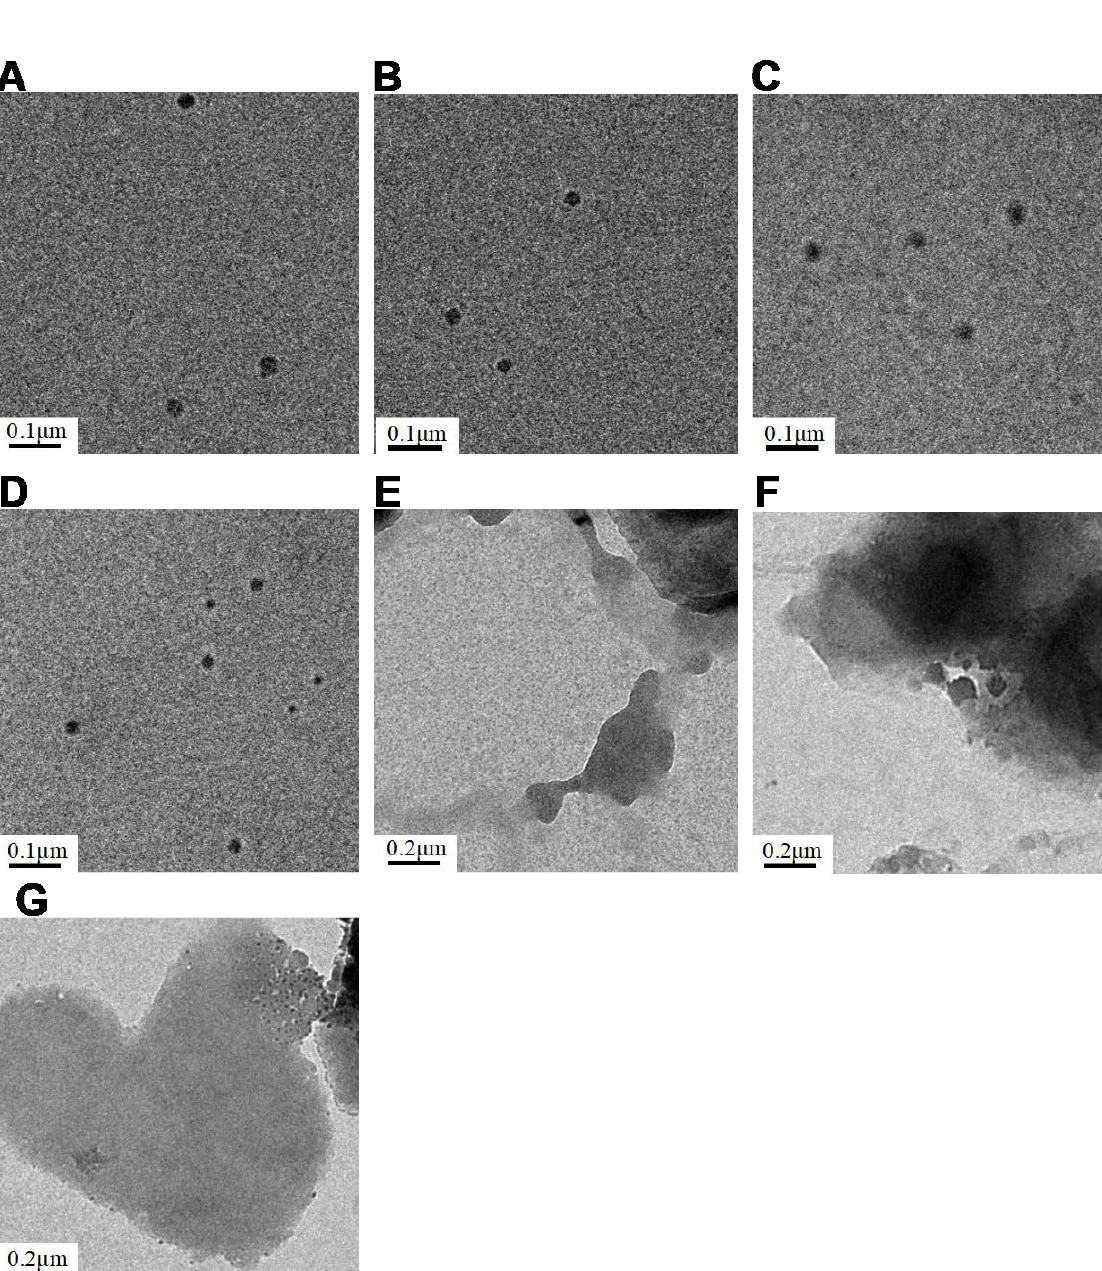
Figure 4. TEM images of MMAF@BBN-PEG-PPADT after ( A ) 0 h, ( B ) 1 h, ( C ) 4 h, and ( D ) 24 h incubation in PBS; and after ( E ) 1 h, ( F ) 4 h, and ( G ) 24 h exposure to ROS conditions.